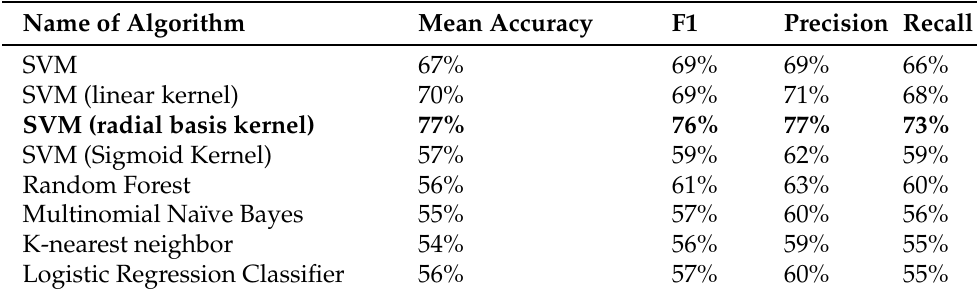
Table 2. Comparison of classification measures of different algorithms which were used to classify the manually labelled sampled data, the value in bold values indicate the highest scores achieved by specified algorithm.